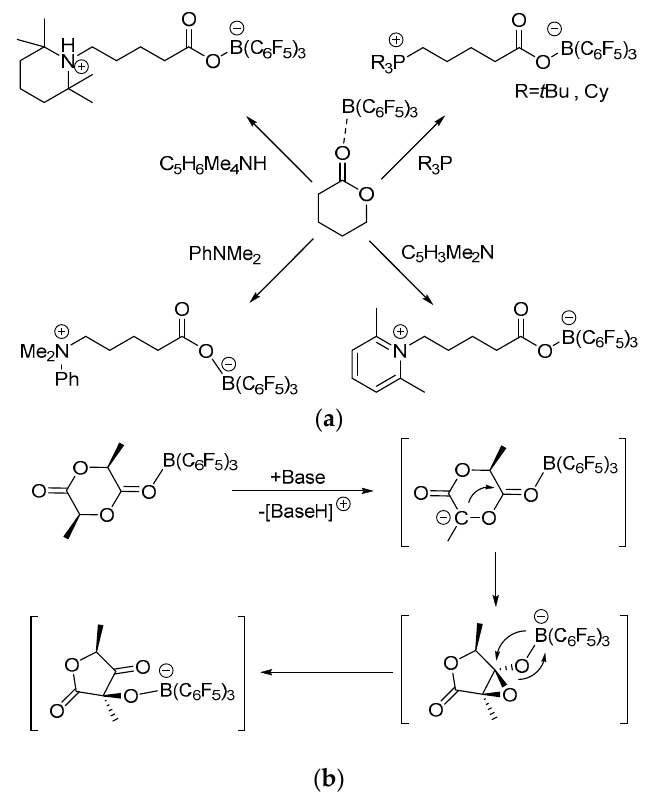
Scheme 3. ( a ) ring-opening of δ -valerolactone; ( b ) Proposed mechanism of lactide ring